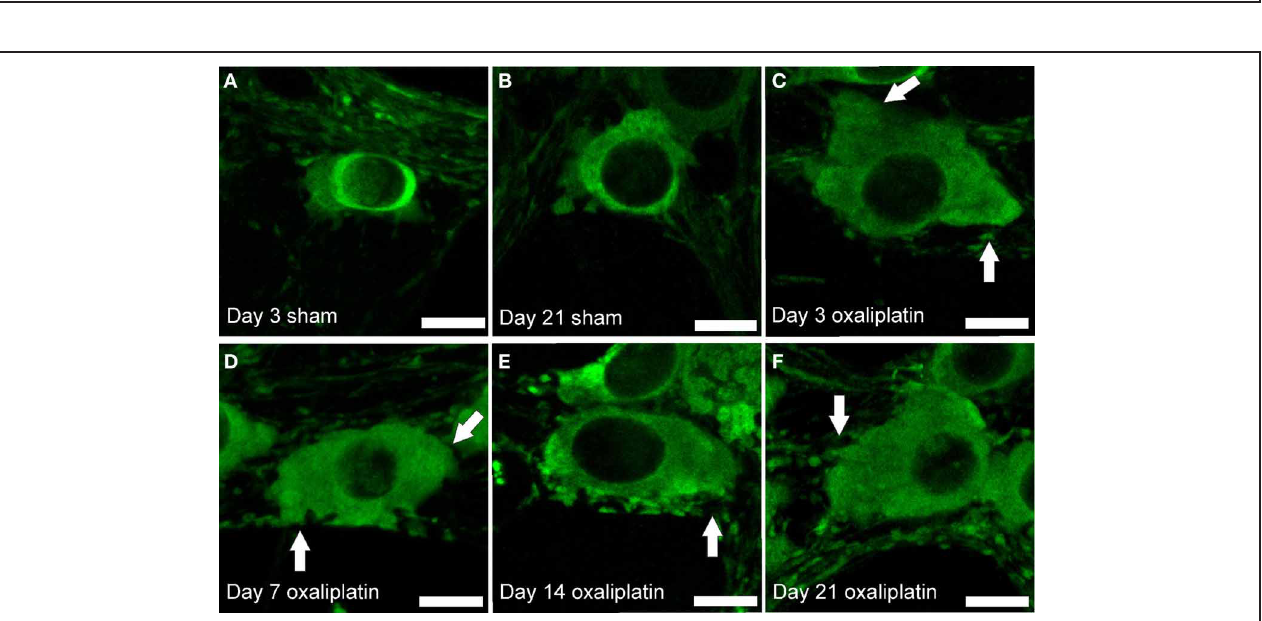
an increase in the soma size and prominent, slightly distorted dendrites (arrows) when compared to the neurons from the sham-treated mice (A,B) . Scale bar = 10 μ m.